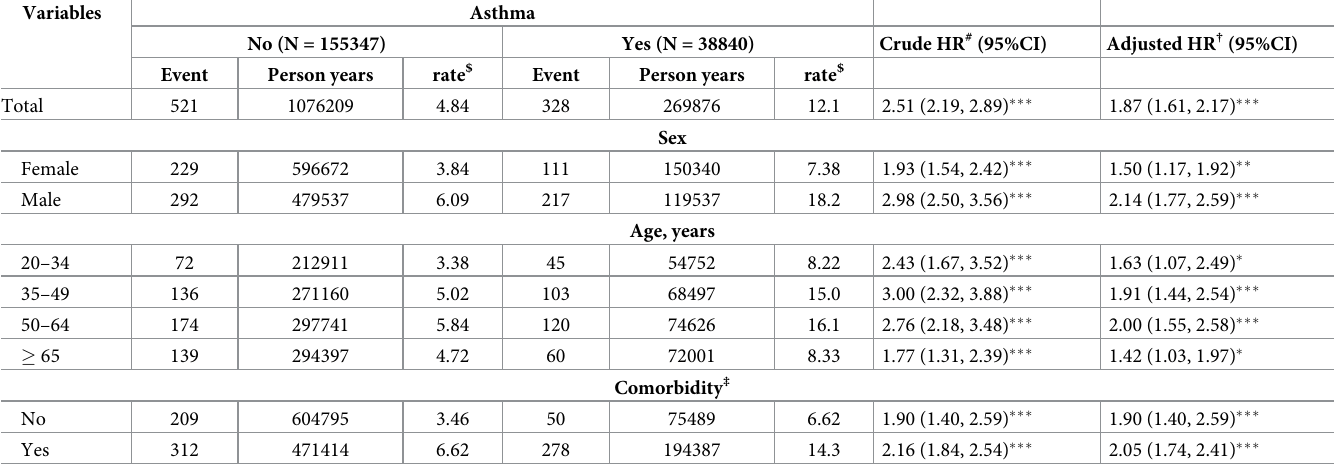
Table 2. Incidence of obstructive sleep apnea and Cox method estimated hazard ratio of obstructive sleep apnea for asthma cohort compared with non-asthma cohort by demographic characteristics and comorbidity. Variables